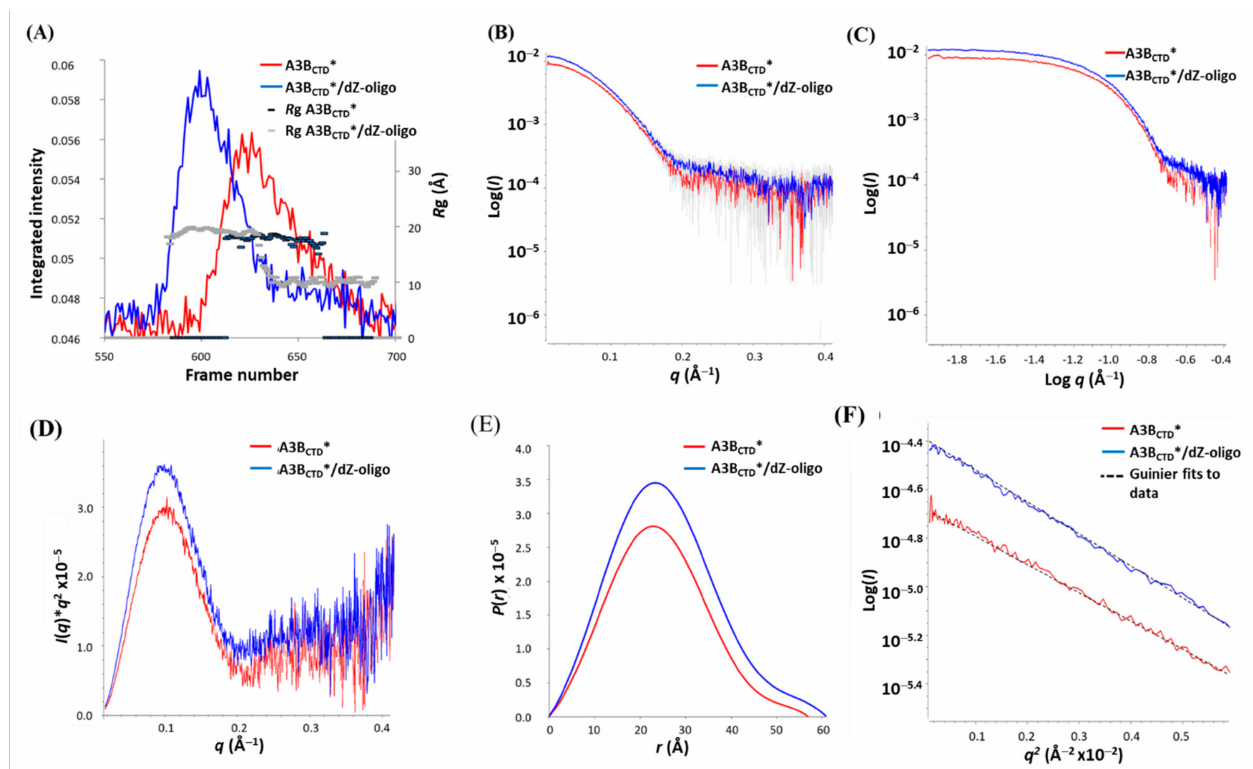
Figure 3. SEC-SAXS analysis of A3B CTD * (red) and A3B CTD */dZ-oligo complex (blue). ( A ) SAXS profile plots. ( B ) Scattering curves log I ( q ) versus q . ( C ) Double log plot of scattering. ( D ) Kratky plot. ( E ) P ( r ) distribution plot. ( F ) Guinier plots. Experiments conducted injecting into SEC-FPLC 5 mg/mL A3B CTD * and A3B CTD */dZ-oligo at a 1 to 2 molar ratio in pH 5.5 buffer (see caption to Figure